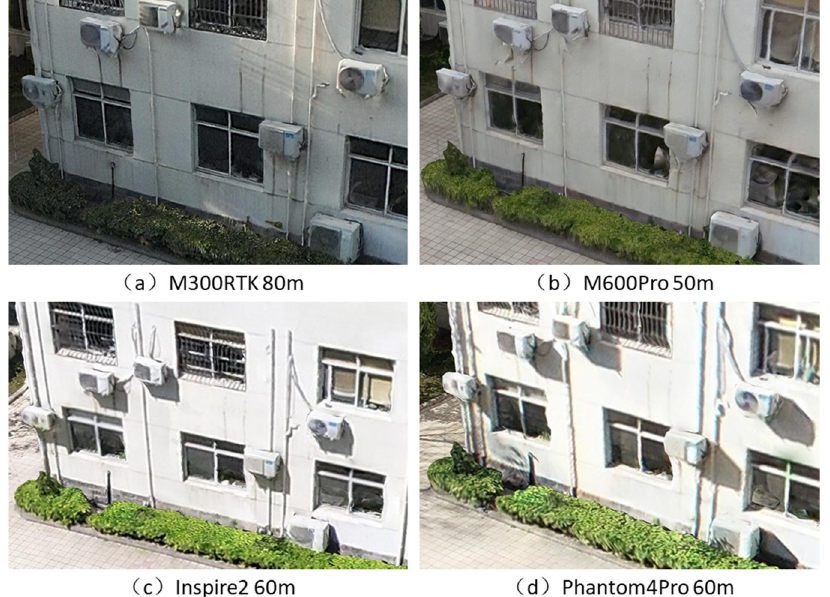
Figure 10. Surface distortion in different 3D reconstruction models. (a) Surface distortion in 3D reconstruction model of M300RTK at 80 m height. (b) Surface distortion in 3D reconstruction model of M600Pro at 50 m height. (c) Surface distortion in 3D reconstruction model of Inspire2 at 60 m height. (d) Surface distortion in 3D reconstruction model of Phantom4Pro at 60 m height.